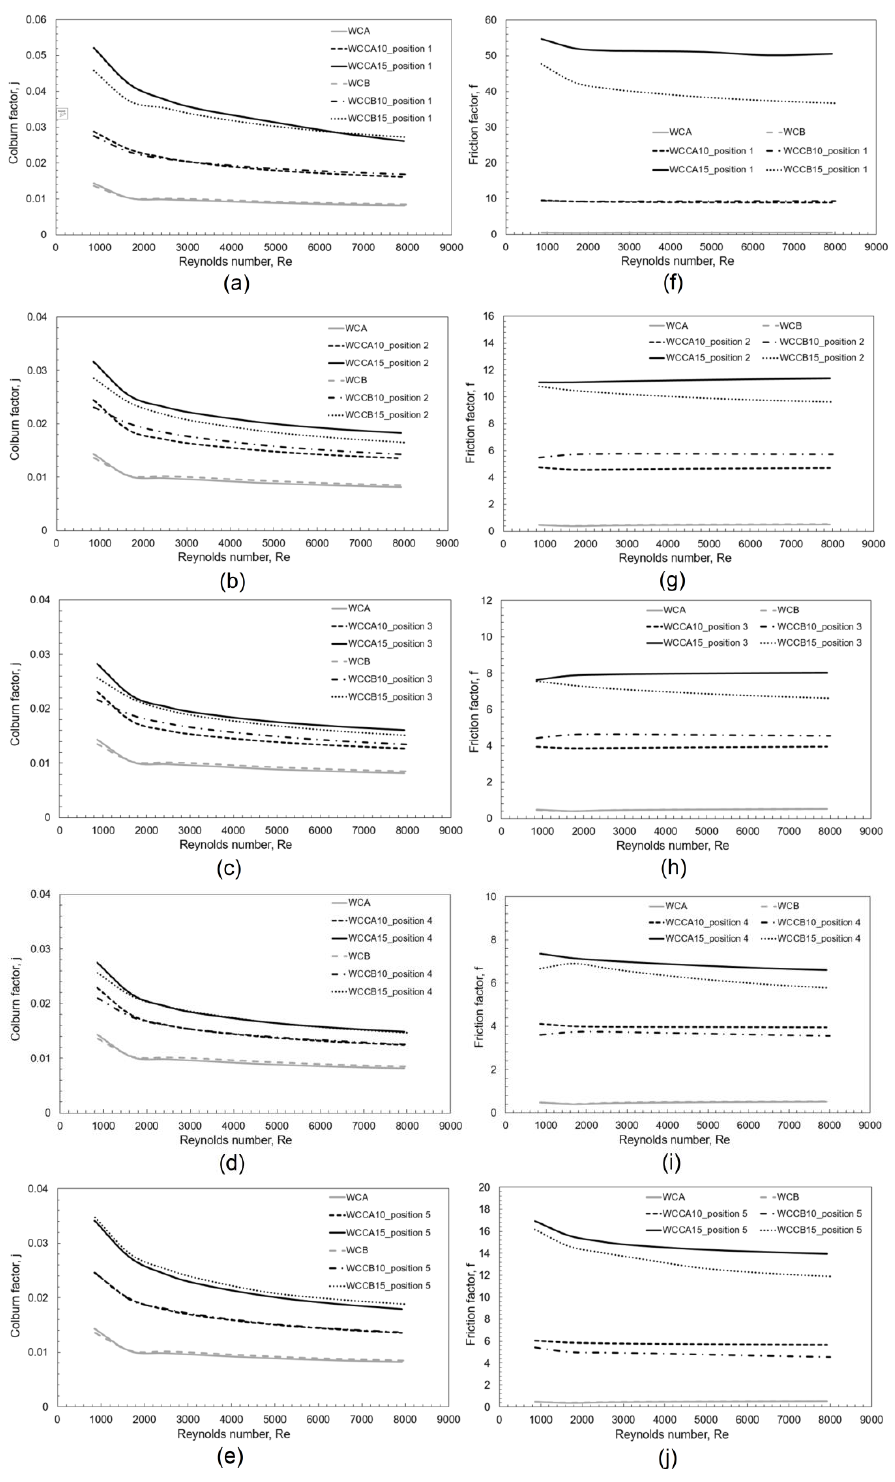
Figure 11. The effect of configuration and position of CVGs on the values of Colburn factor and Friction factor when changing Reynolds number, ( a – e ) WC vs. WCC at the position ‘1’ to ‘5’ in terms of Colburn factor, ( f – j ) WC vs. WCC at the position ‘1’ to ‘5’ in terms of Friction factor.